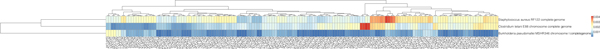
The AATTCG-Spectrum set test: The genomes or chromosomes are analyzed by base composition to determine the expected clustering behavior of their contigs.